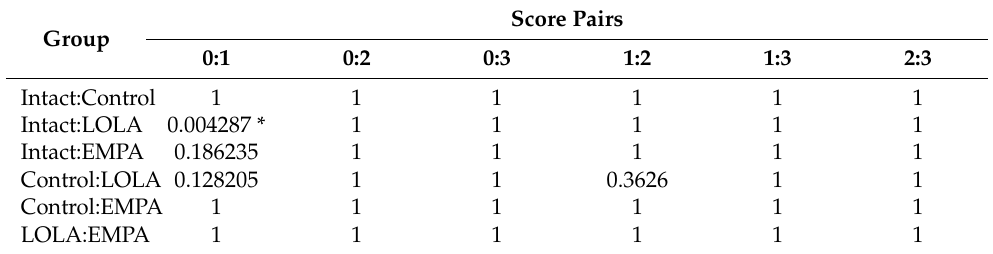
LOLA:EMPA * indicates significance. Table A8. Adjusted p -values for bridging fibrosis score frequency distributions. Group